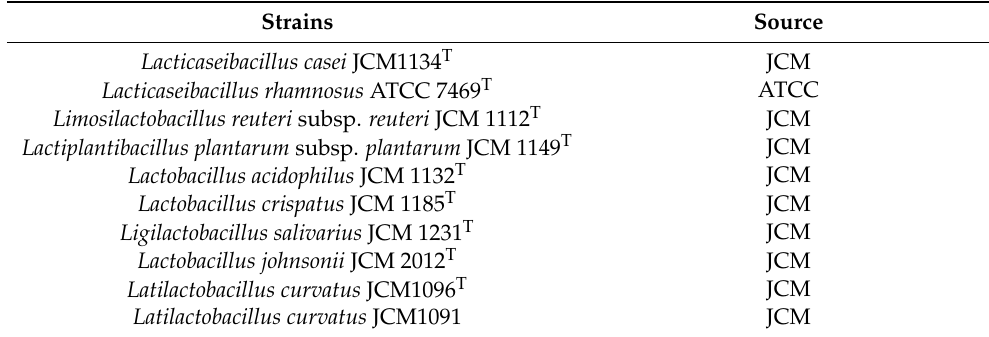
Figure 3. Spermidine concentration in culture supernatant and in the cells of lactic acid bacterial strains. Lactic acid bacterial strains were cultured in the MRS medium anaerobically for a maximum of 82 h at 37 ◦ C. Spermidine concentration in culture supernatant ( A ) and intracellular spermidine concentration ( B ) of the tested lactic acid bacterial strains in the growing phase and stationary phase. For ( A ), the values are shown as changes in the amount of polyamine from the MRS medium to the culture supernatant. White bars, growing phase; black bars, stationary phase. Data represent means ± standard deviation from biological replicates ( n = 3). Table 3. List of strains used for comparison of the polyamine synthesis ability with L. curvatus KP